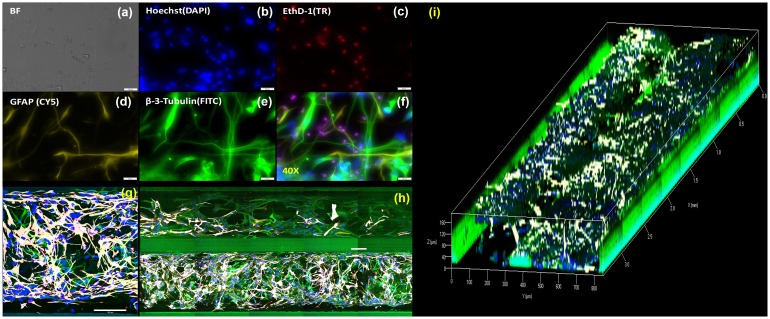
Dynamic 3D brain tissue construct with human iPSC-derived GABAergic neurons and astrocytes.(a) Bright-field image, (b) Hoechst: nuclei, (c) EthD-1: dead cells, (d) GFAP: astrocytes, (e) β-tubulin III: neurons, (f) Overlay image, (g) Top view of neurons (green) and astrocytes (white) in the cell-gel matrix, (h) Top view of brain tissue construct showing cell-gel matrix and perfusion lane, and (i) 3D render of entire brain-on-chip construct. Scale Bar: (a)-(f) = 20 μm, (g)-(h) = 100 μm.